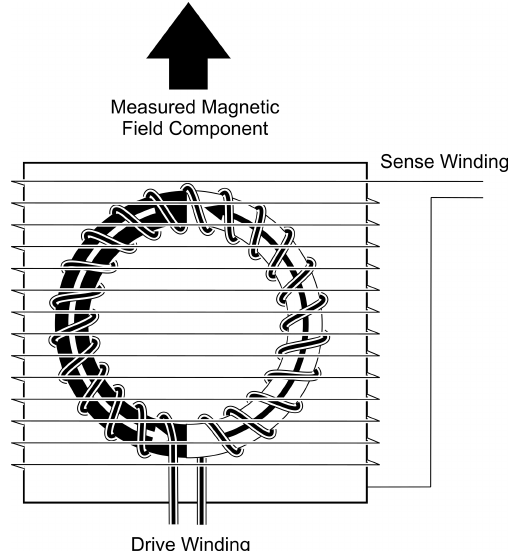
Figure 1. A fluxgate sensor has three primary components: a ferro- magnetic core, a drive winding to periodically force the ferromag- netic core into magnetic saturation, and a sense winding to pick up the modulated (gated) field. Reproduced from Miles et al. (2017).